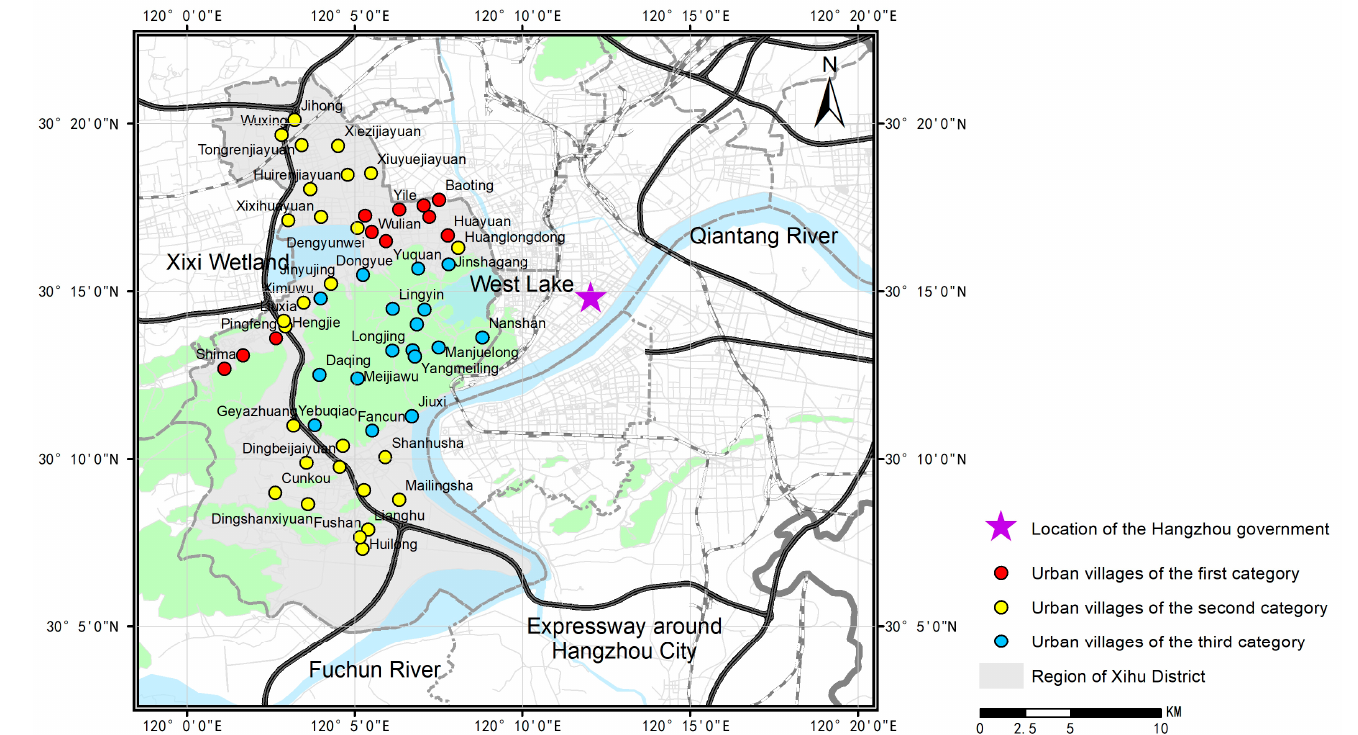
Figure 8. Spatial distribution of the selected urban villages for comparison.